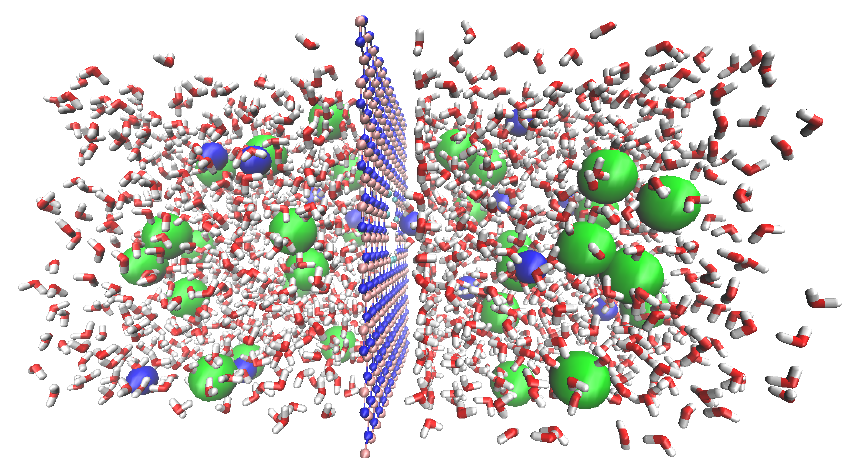
Fig. 1: A snapshot of the simulated system. The BNNS membrane with a functionalized pore in its center is located in the middle of simulation box (red: O, white: H, blue: Ni, and green: Cl).